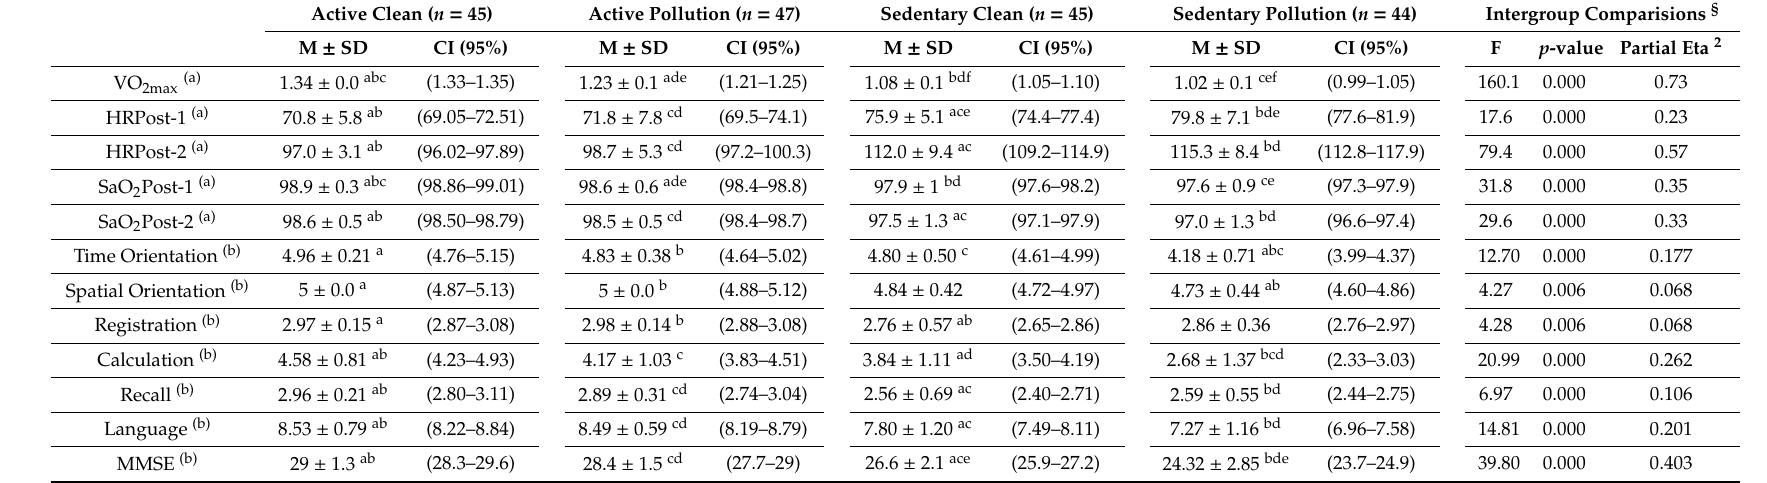
Table 4. Intergroup comparisons posttest